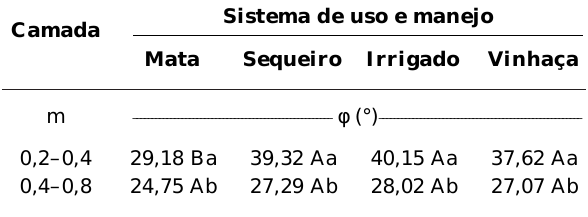
Ds, Mg m -3 Figura 4. Ângulo de atrito interno do solo ( φφφφφ ) de acordo com a densidade do solo (Ds).